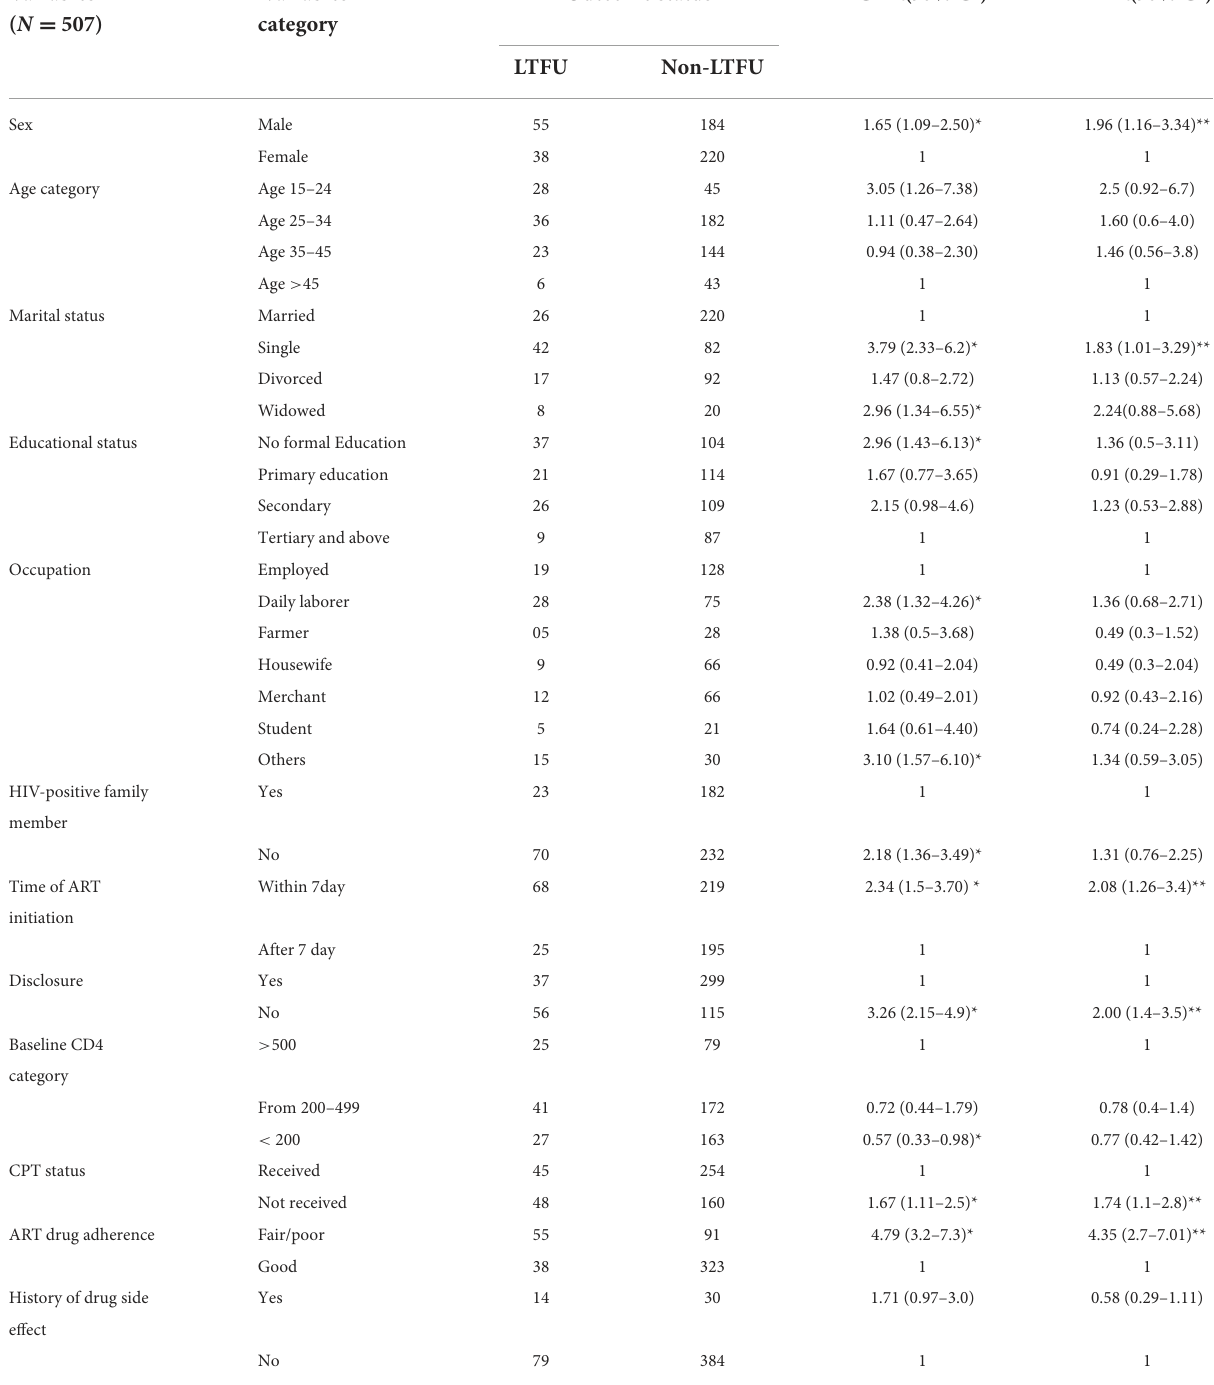
TABLE 3 Bivariable and multivariable Cox regression analysis predictors of LTFU among adults on ART at FHCSH, Northwest Ethiopia,